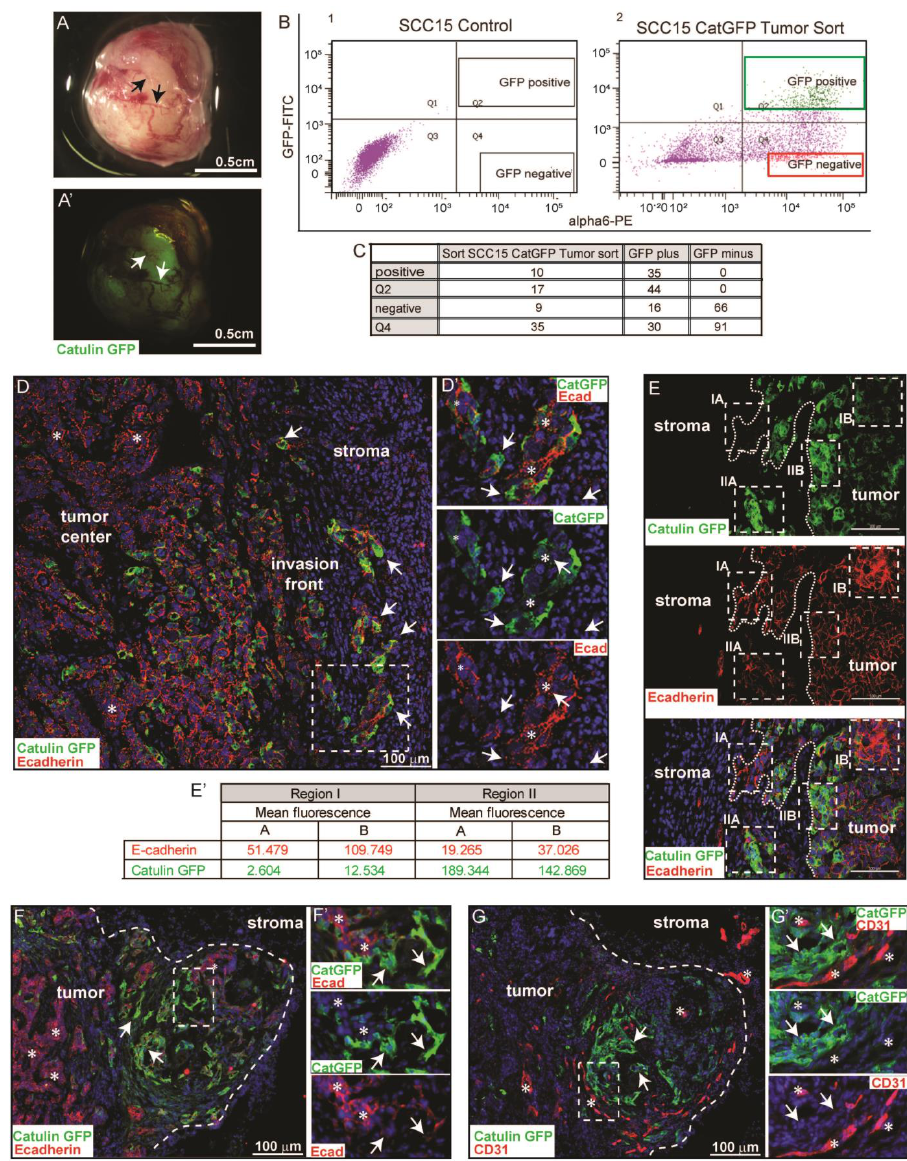
Figure 3. Catulin-GFP reporter system marked a small population of cells at the tumor invasive front. ( A , A ′ ) Dissection-scope picture of tumor formed after the injection of the SCC15CatGFP reporter cell